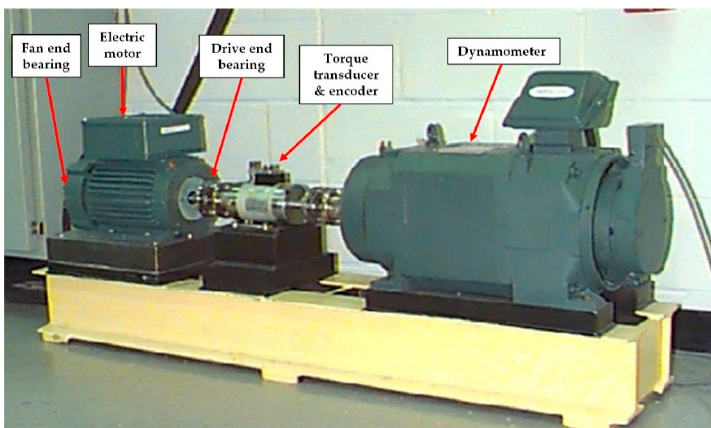
Figure 5. Experimental platform for acquiring vibration signals from rolling bearings.